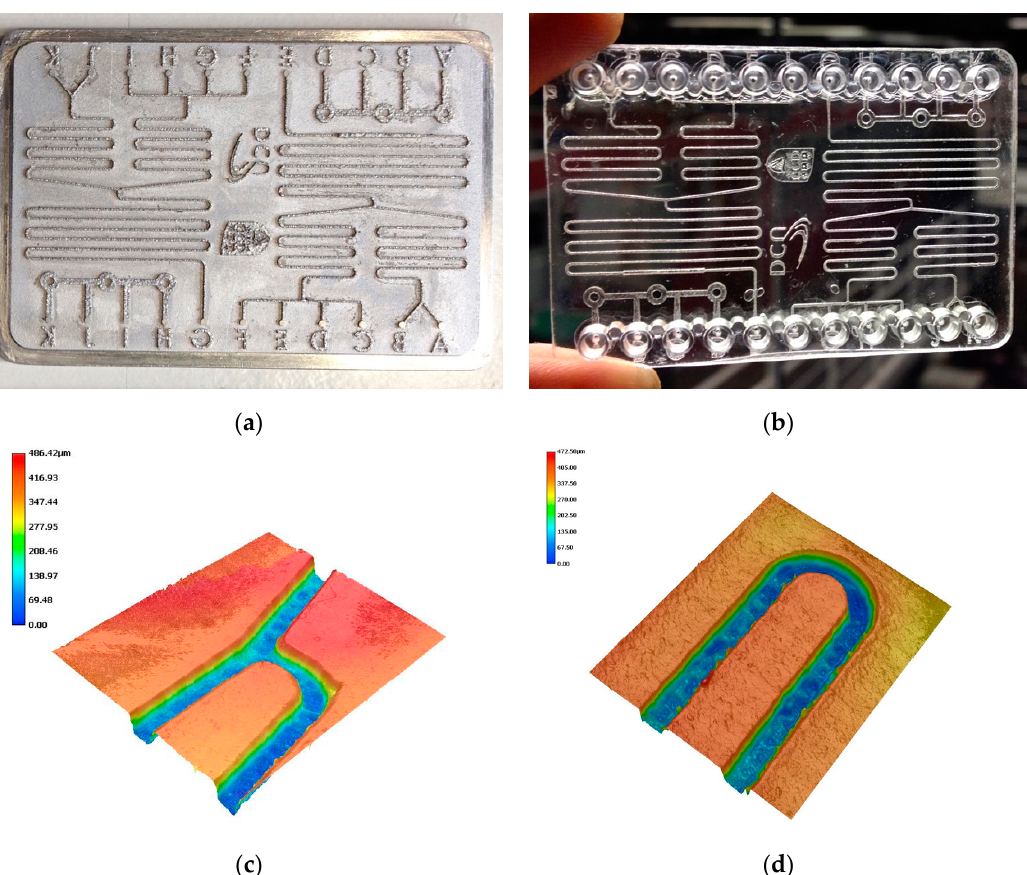
Figure 14. ( a ) SLM printed moulds after polishing, ( b ) injection moulded cyclic olefin copolymer (COC) microfluidic chip, and ( c ) and ( d ) 3D images of plastic chip.